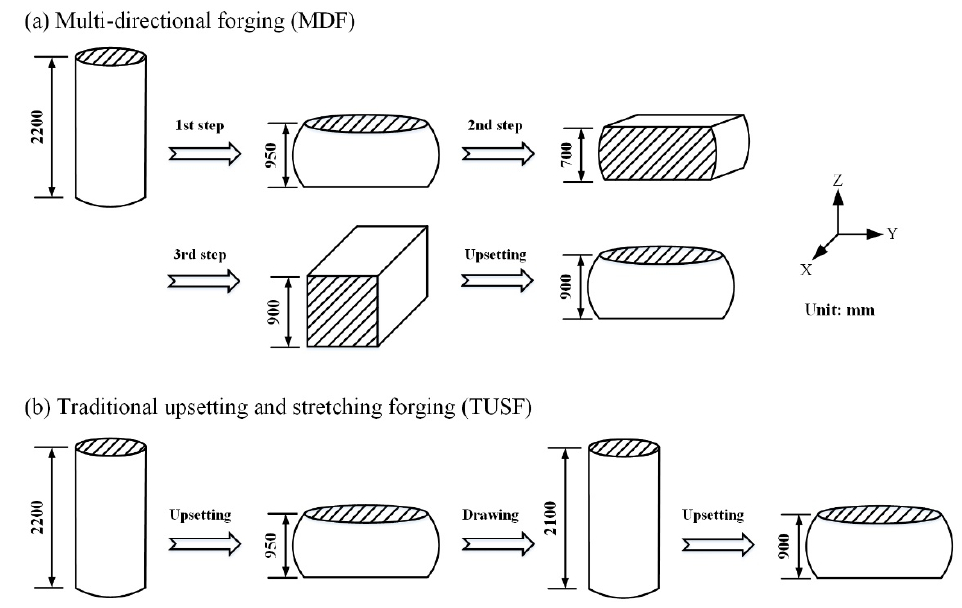
Figure 6. Schematic of ( a ) MDF and ( b ) traditional upsetting and stretching forging (TUSF) pro-